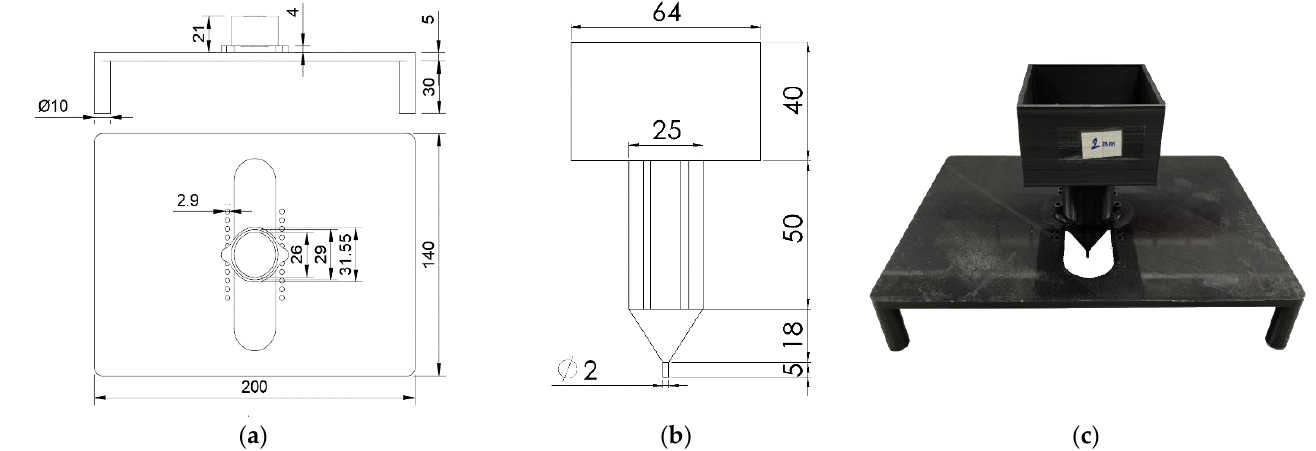
Figure 1. ( a ) Rack structure sketch: front and top view; ( b ) pressing tool sketch; ( c ) photograph of the rack structure. rack